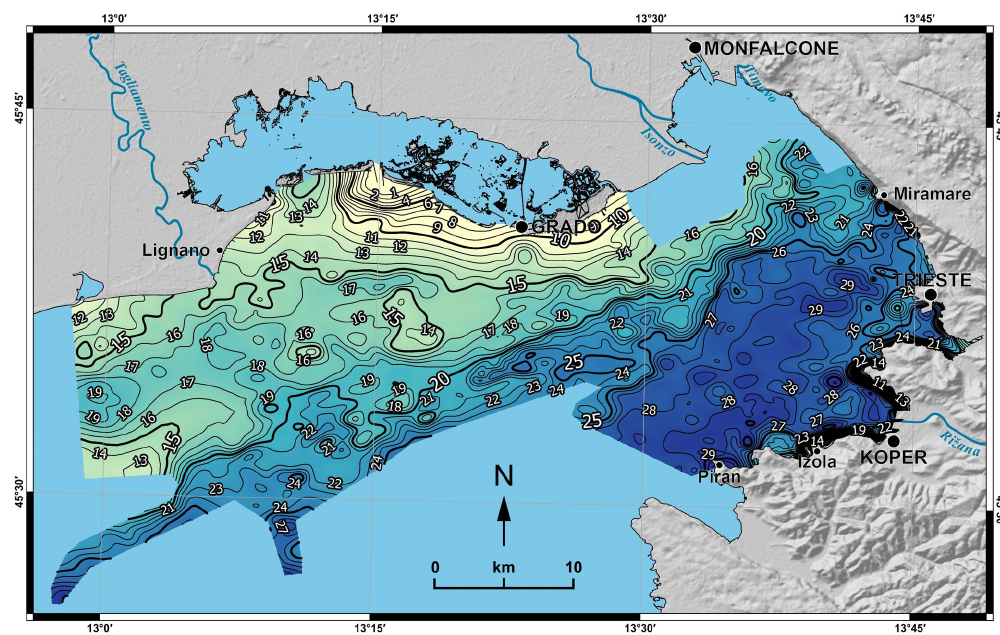
Figure 7. Map of the depth of the base of the Holocene marine sediment in